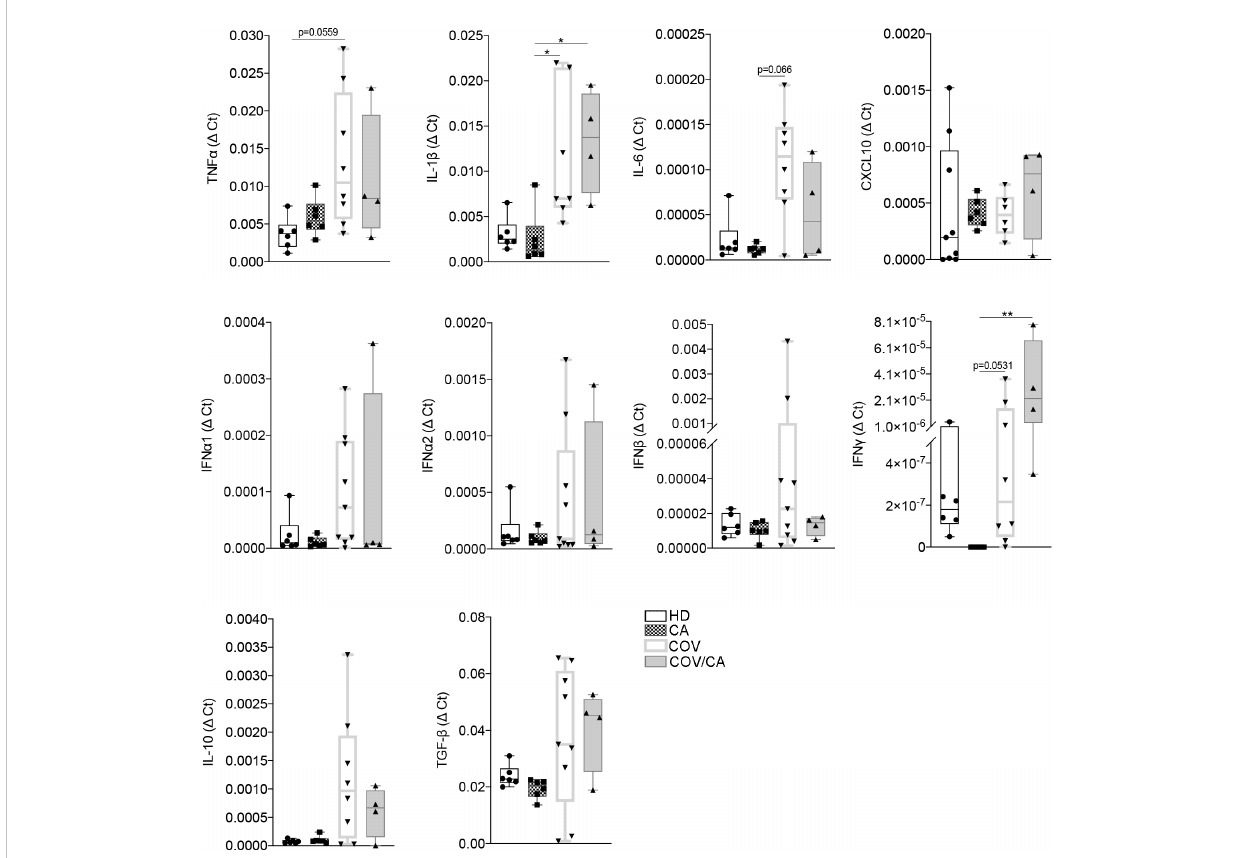
FIGURE 3 Cytokine gene expression in freshly isolated PBMCs from our study cohorts. Box-and-whisker plots representing mRNA levels of the indicated pro- and anti-in fl ammatory cytokines in freshly isolated PBMCs from HD ( n = 6), CA ( n = 6), COV ( n = 8) and COV/CA ( n = 4) patients. Boxplot representation (centre line, mean; box limits, upper and lower quartiles; whiskers, range; points, data points per patient). Statistical signi fi cance of differences between patient groups was calculated using one-way ANOVA followed by Tukey ’ s multiple comparison test or a Kruskal-Wallis test followed by Dunn ′ s multiple comparisons test. * P < 0.05, ** P < 0.01 between selected relevant